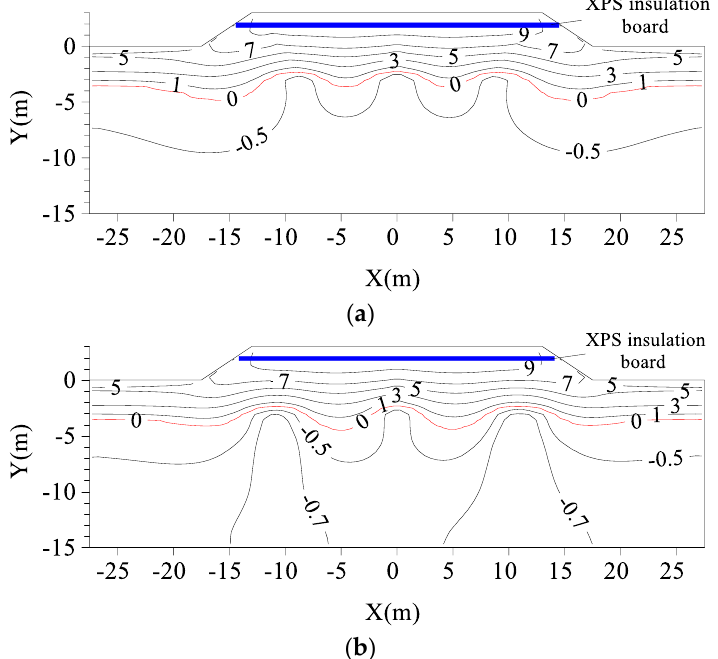
Figure 11. Geotemperature distributions of the composite subgrade on 1 October of the 30th year after their construction (Unit: °C ): ( a ) α = 50°; ( b ) α = 70°.